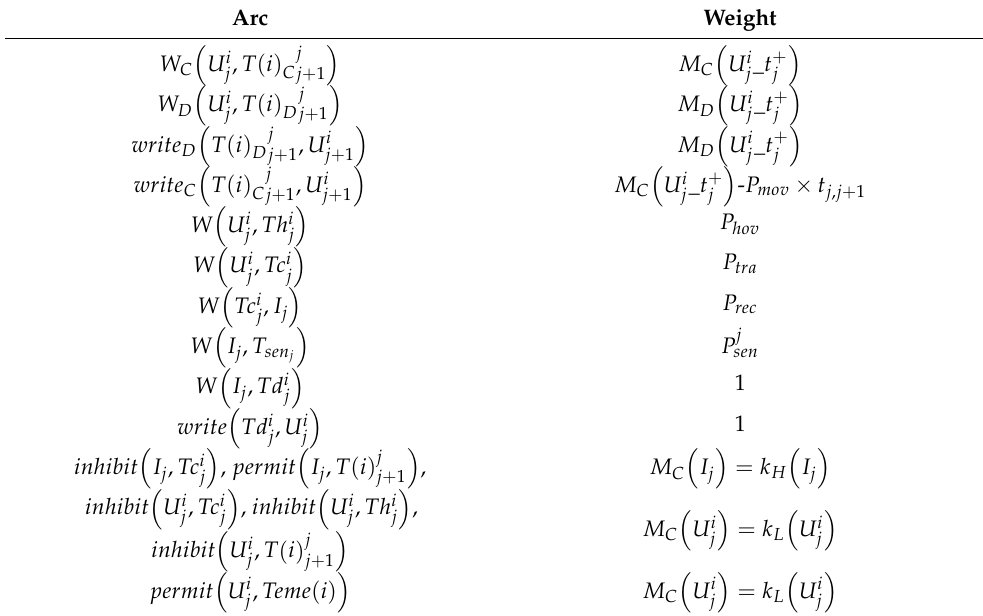
Table 3. Description of representative arcs.